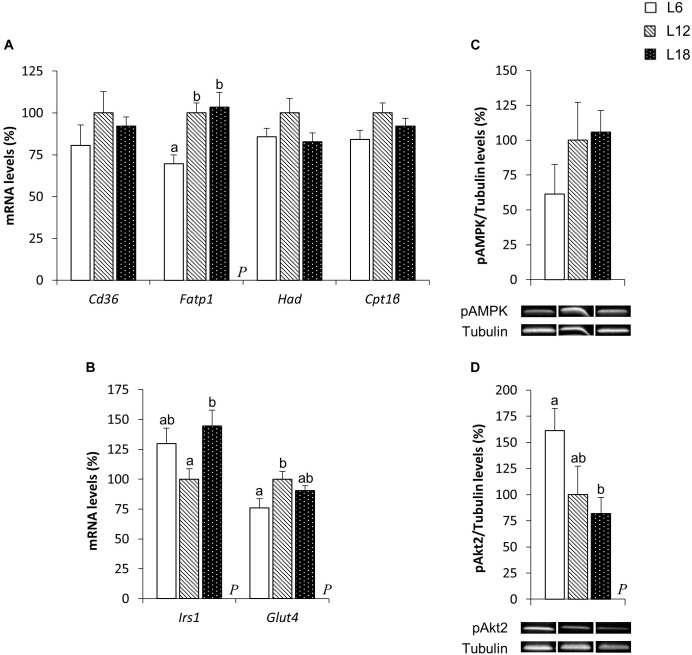
The mRNA expression of genes involved in lipid (A) and glucose (B) metabolism and pAMPK (C) and pAkt2 (D) protein levels in the soleus muscle of male F344 rats exposed to three different photoperiods for 11 weeks and fed a cafeteria diet for the last 7 weeks. Data are expressed as the mean ± SEM (n = 8). P, photoperiod effect. abMean values with unlike letters were significantly different among groups (one-way ANOVA and Duncan’s post hoc test). Cd36, fatty acid translocase, homolog of CD36; Cpt1β, carnitine palmitoyltransferase 1 beta; Fatp1, fatty acid transport protein 1; Glut4, glucose transporter 4; Had, hydroxyacyl-CoA dehydrogenase; Irs1, insulin receptor substrate 1; pAkt2, phosphorylated Akt serine/threonine kinase 2; pAMPK, phosphorylated AMP-activated protein kinase.